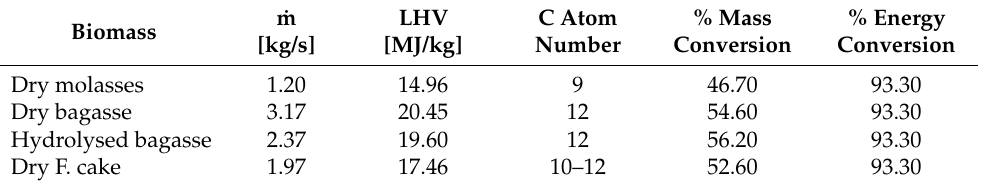
Table 8. Stoichiometric carbon capturing efficiency in biomass to alcohol